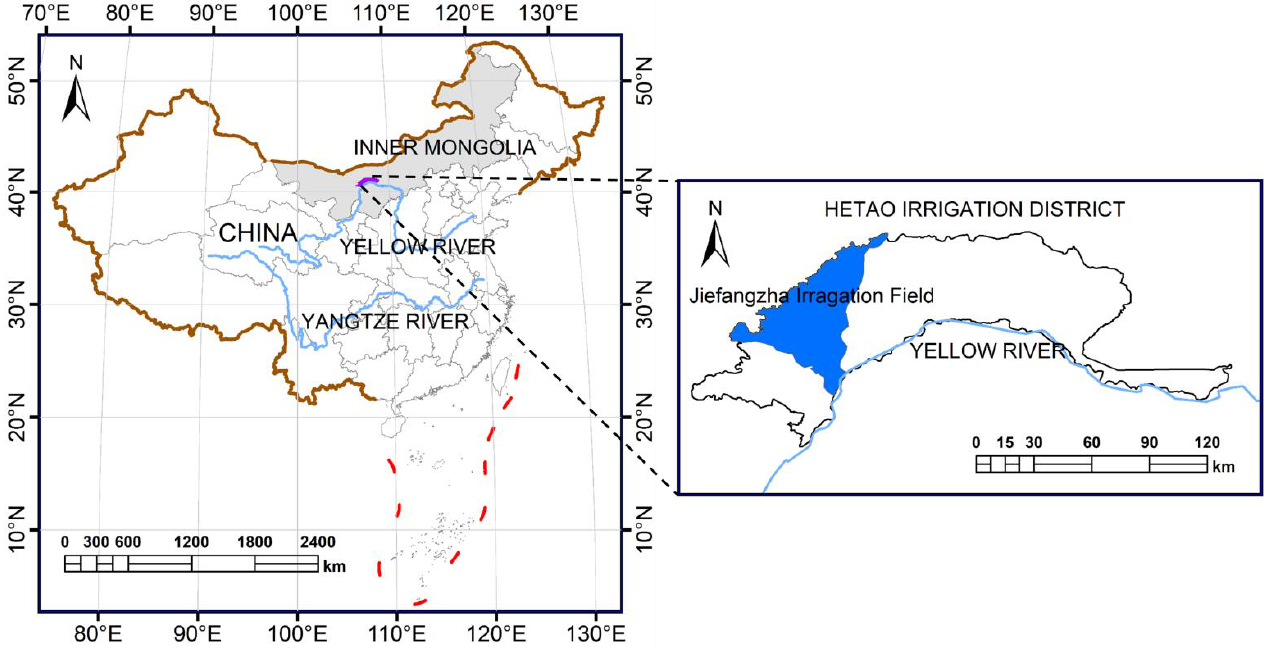
Figure 1. The geographical position of the Jiefangzha Irrigation Field.